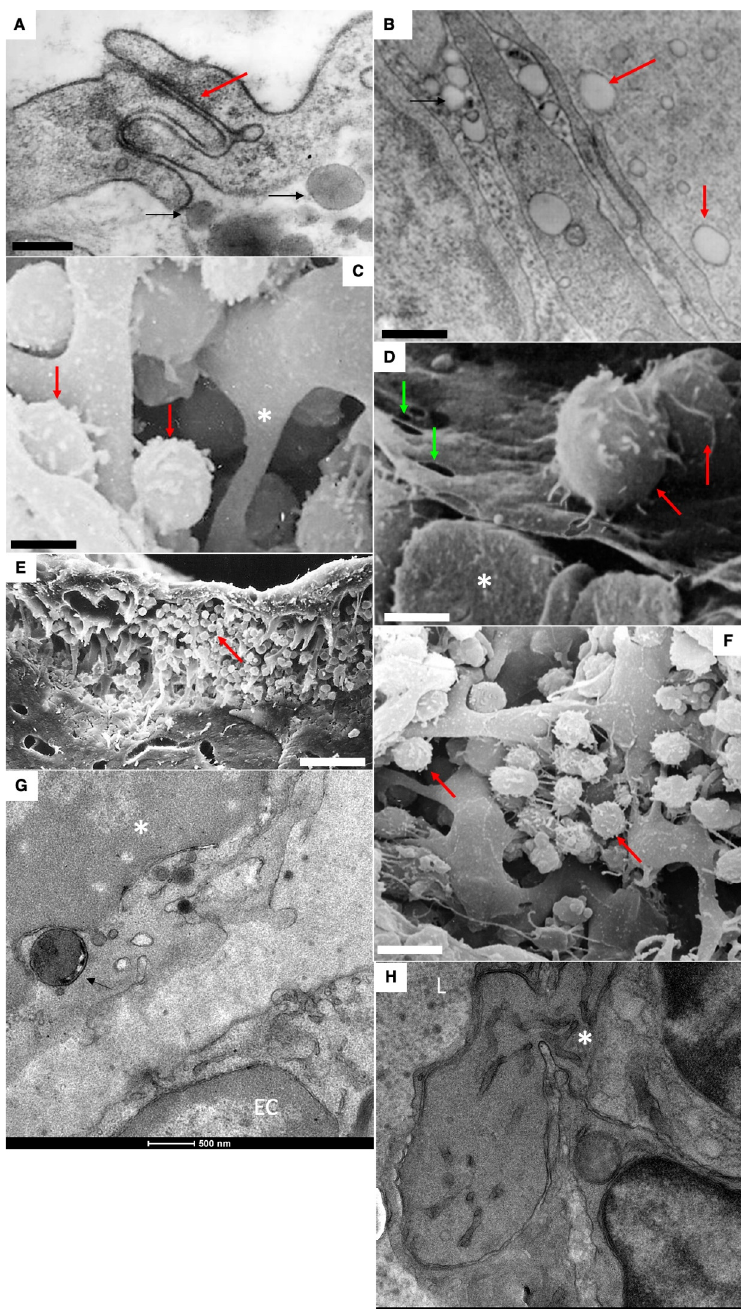
Figure 8. Mechanisms of resorption of large ChMs from the interstitial space into LCs of a newborn rat after feeding. ( A , B ) The lumen of LC is filled with ChMs (shown by the arrow). Large lipid droplets are visible in the interstitial (shown by the black arrows). ( B ) Interdigital contact between endothelial cells in LCs does not allow ChMs (arrows) to pass through it. ( C – H ) Migration of macrophages into subcapsular sinus of lymph node after the first feeding. Uptake of large chylomicrons by macrophages ( G ). Red arrows in all images indicate leucocytes. White asterisks demonstrate monocytes. Green arrows show pores in endothelial cells surrounding the sinus from the follicular side. Scale bars: 420 nm ( A ); 560 nm ( B ); 5.4 µ m ( C ); 4 µ m ( D ); 30 µ m ( E ); 10.8 µ m ( F ). In images ( G , H ), scale bars are below images and are equal to 500